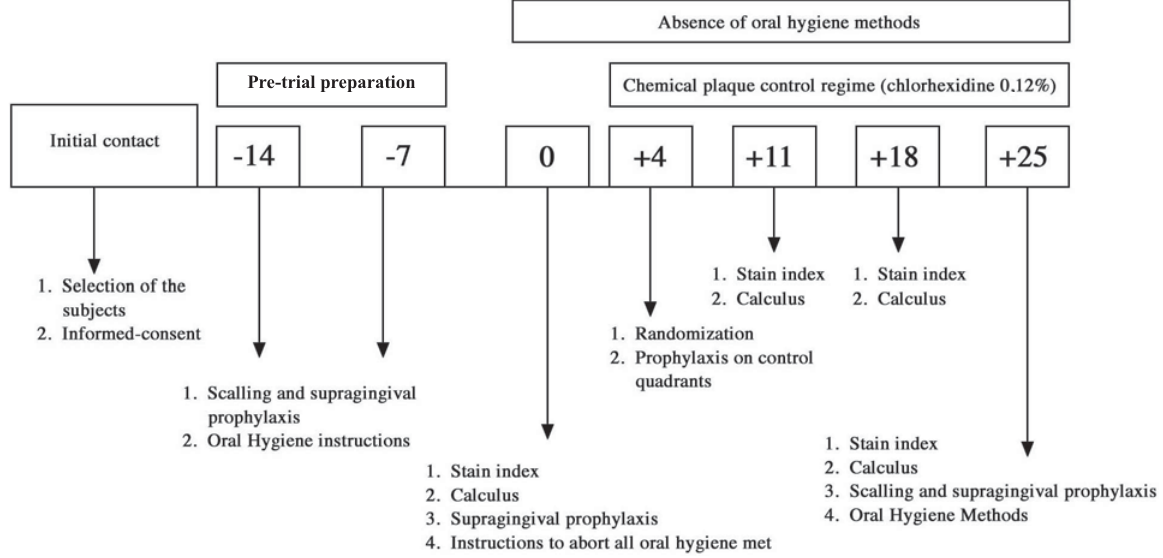
Figure 2- Experimental design